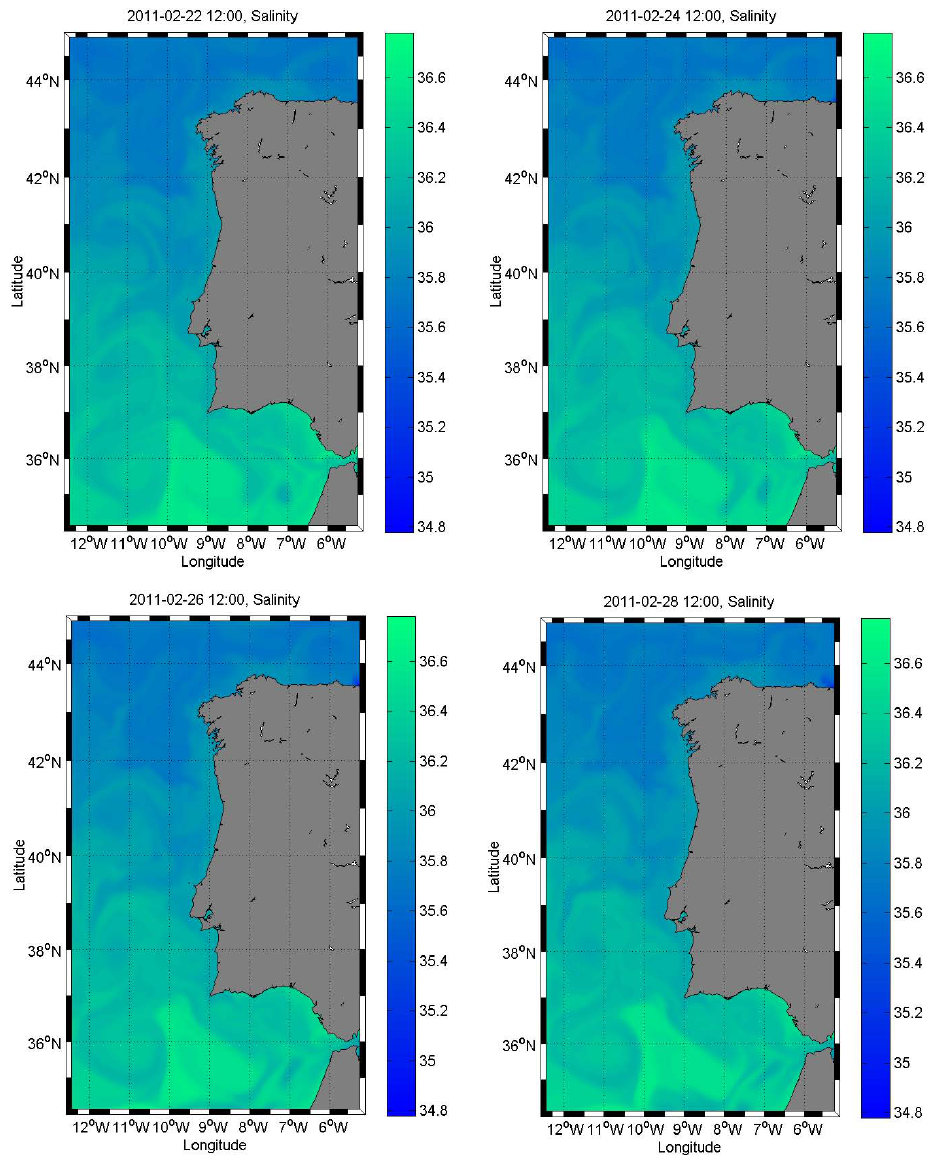
Fig. 3. Snapshots of sea surface salinity predicted by the model from 22 to 28 February 2011.